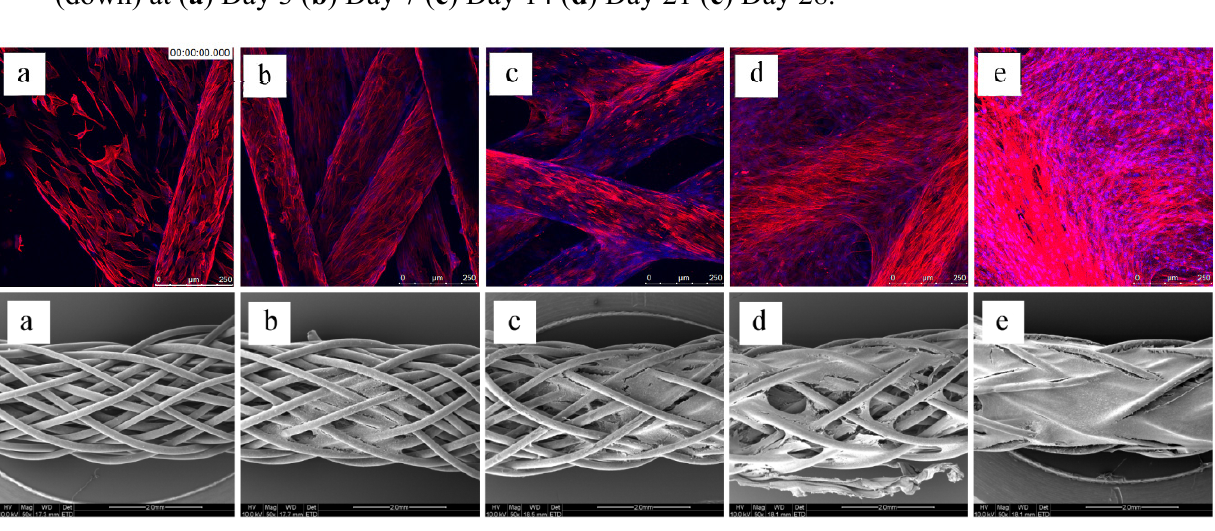
Figure 5. Macroconfocal images of scaffolds cultured three days in the bioreactor and seeded with ( a ) 200,000 cells ( b ) 600,000